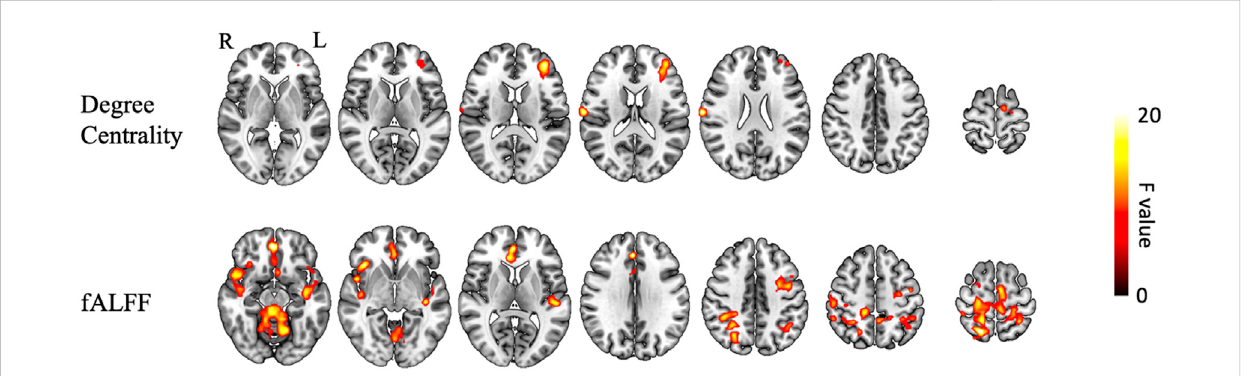
FIGURE 2 Interaction of brain function between NXA group and ginkgo group before and after treatment. The signi fi cance level was set at a voxel-level inference of p < 0.001 combined with a cluster-level inference of p < 0.05 (GRF-corrected). Abbreviation: fALFF = fractional amplitude of low-frequency fl uctuations, L = left, R =